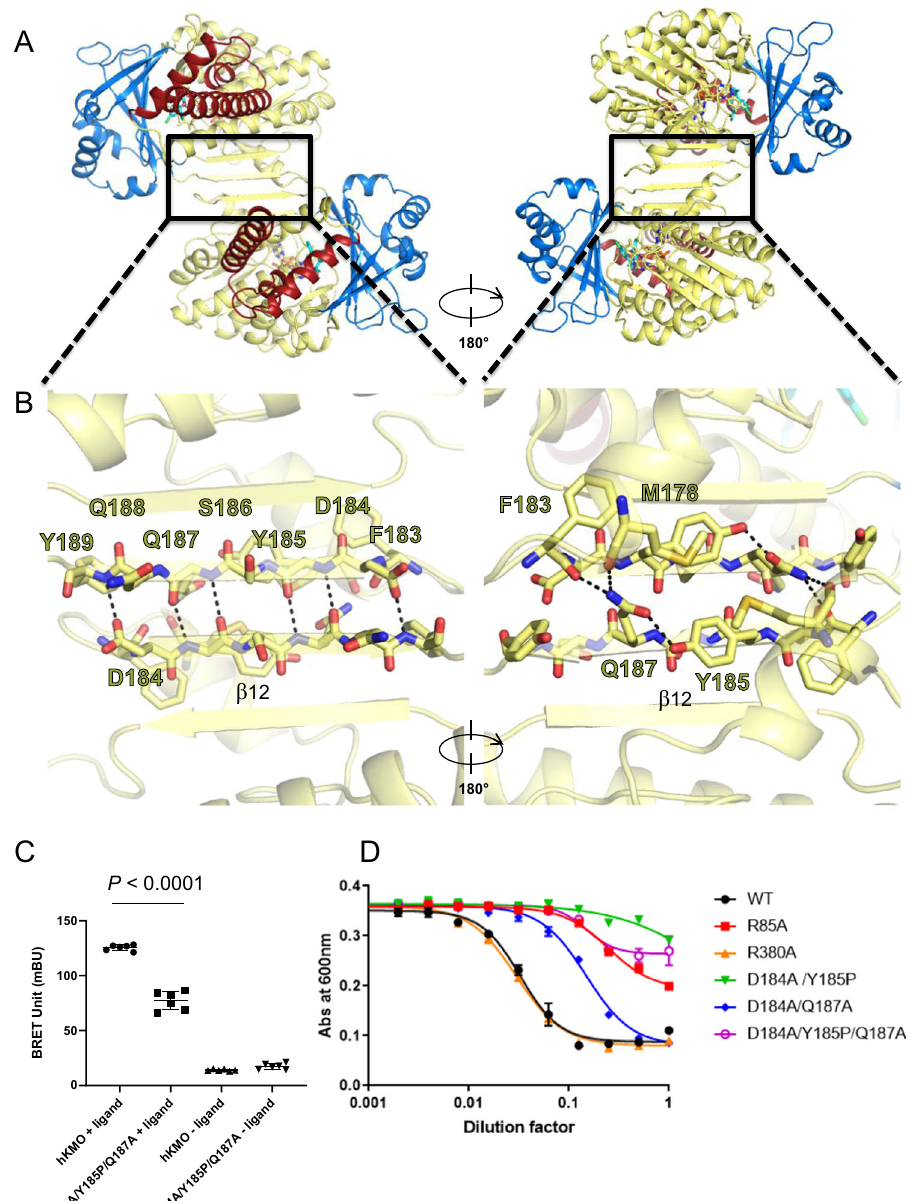
Fig. 4 Dimerisation and functional investigation. A , B Inter- β -sheet hydrogen bonds observed in domain I of Rat-KMO. The crystallographic dimer has 10 hydrogen bonds, in addition to intra hydrogen bonds, linking the dimers. Sticks and secondary structures are coloured using the same scheme as that in Fig. 1. C Dimerisation assays for Hs-KMO using NanoBRET. BRET units of non-GST-tagged Hs-KMO and its mutant were measured in HEK293T cells. Mutations at the dimer interface result in signi fi cantly lower BRET signals. Error bars represent standard deviation ( n = 6, * p < 0.0001, two-tailed unpaired Student ’ s t -test). D Functional assay of Rat-KMO mutants in mitochondrial membranes. All mutants decreased catalytic activity of Rat-KMO, with activity being almost completely abolished in the presence of the β -sheet-disrupting Y185P mutation. For each sample, the enzyme concentration dilution factor (x-axis) is normalised to the intensity of anti-GST from western blot Human and rat KMO enzyme assay . All information relevant to compound Ligand docking and human KMO model construction . Ligands were docked synthesis of compounds 1 – 5 are in Supplementary Note 1. Human KMO was using Schrodinger Maestro software (Schrödinger). Rat-KMO in complex with purchased from Origene and used to assay compounds. Full-length Rat-KMO compound 3 was selected for docking because its side chains resembled previously puri fi ed for crystallisation was used to assay compounds. Full-length Rat-KMO- reported structures. The PDB fi le was prepared using the protein preparation. The expressing membranes were used for mutant assays (Fig. 4b) only. Mutant Rat- compound 3 binding site was used as the centroid for generating the ligand- KMO expressed in membranes was quanti fi ed by western blotting using anti-GST binding grid. Ligands were prepared using Ligprep and docked using GLIDE. (Anti-GST-tag pAb (MBL Code No.PM013)) and IRDye 800CW Goat anti-Rabbit Docked compounds were selected based on whether the polarised or (LI-COR Biosciences Cat# 926-32211 ) antibodies (Supplementary Table 4). Images hydrophobic regions of the compounds fi t into the respective regions of the KMO were taken using Odyssey CLX (LI-COR Biosciences) and quanti fi ed using Ima- pocket. The carboxylic acid moiety of the compound interacts with polarised KMO geStudio2.0 (LI-COR Biosciences) software. residues such as R85, and the hydrophobic regions of the compounds fi t into the Test compounds were dissolved in DMSO and diluted with assay buffer hydrophobic sides of the KMO pocket. All docked structures were among the top 5 containing 50 mM HEPES, 2 mM MgCl 2 , 0.5mM EGTA, 1mM DTT, 0.05% docked sites, and kynurenine was the top ranked structure.